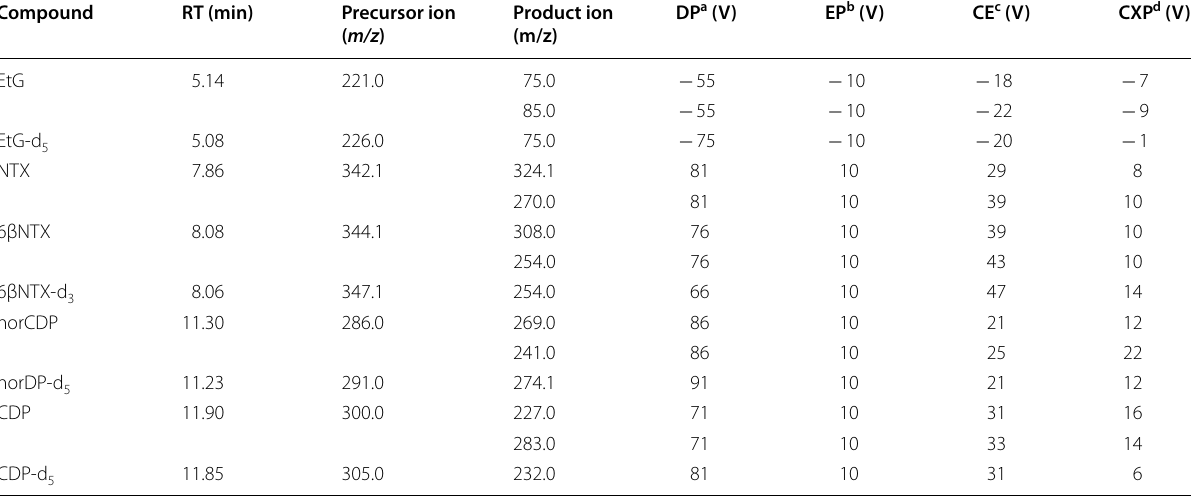
Fig. 2 Chromatograms of EtG for four types of columns: a Zorbax SB-C18 (2.1 75 mm, 3.5 μm), b Scherzo SM-C18 (2.0 × Hypersil Gold (2.1 150 mm, 5.0 μm), and d Waters Xselect HSS T3 (2.1 150 mm, 2.5 μm). The columns were tested in isocratic mode (water × × containing 0.05% formic acid: methanol 70:30) at flow rate of 0.2 mL/min = Table 1 Retention time (RT), MRM transitions, and mass spectrometric